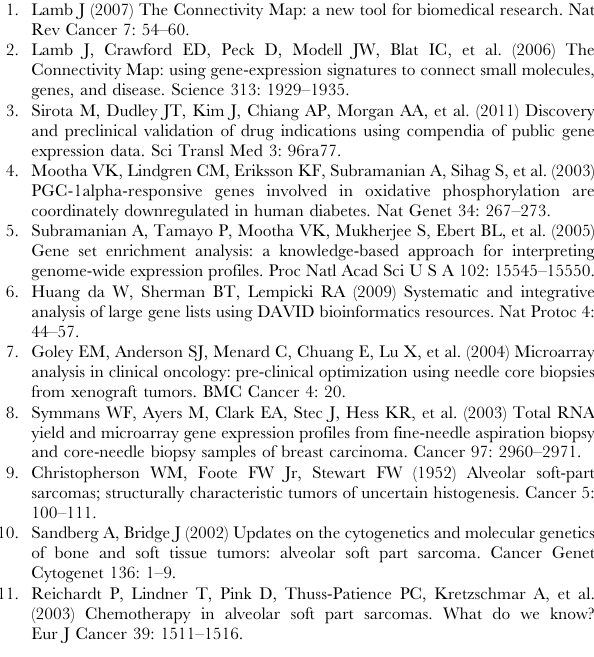
Table S1 GSEA Pathways and Pathway Genes for the DEND meta-clades derived from the clustering of ASPS-tissue genes (See Figure 3 ). Table S2 GSEA Pathways and Pathway Genes for the DEND meta-clades derived from the clustering of ASPS-1 genes (See Figure 4 ). Table S3 GSEA pathways for genes associated with SOM meta- clades 7, 6, 10, 3 and 5. Table S4 GSEA pathways for genes associated with SOM meta- clades 2,9,1,8 and 4. Table S5 Results for convergent pathways derived from the pooled ASPS-1 and ASPS-tissue analysis and the SOM-based analysis of individual patient gene expressions. Column 1 lists the meta-clade identifiers (DEND meta-clade: SOM meta-clade), column 2 lists the GSEA pathways and column 3 lists the pathway genes identified from each